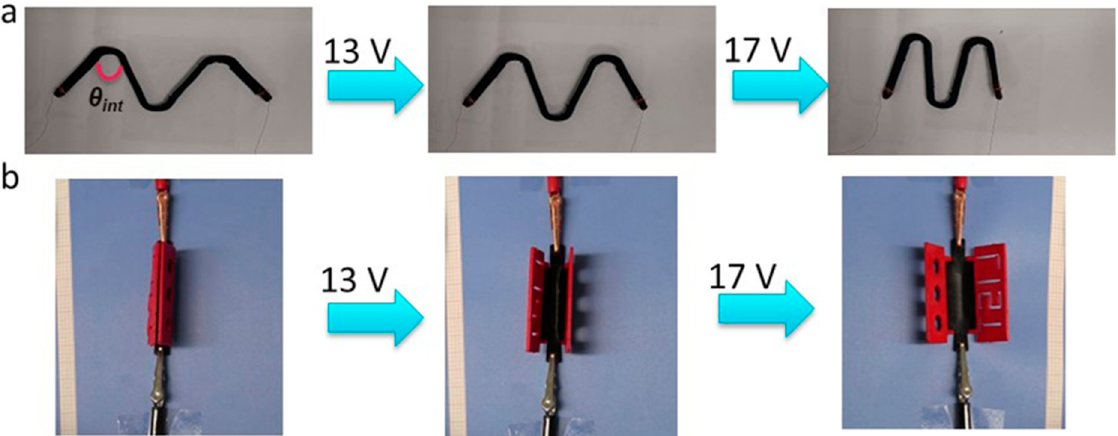
Figure 8. Electrically triggered TSE in 3D-printed composites samples ( a ) “M” shaped sample based the electroactive composite, ( b ) multi-material hinge structure consisting of electroactive composite (black) and passive PLA subcomponents (red).